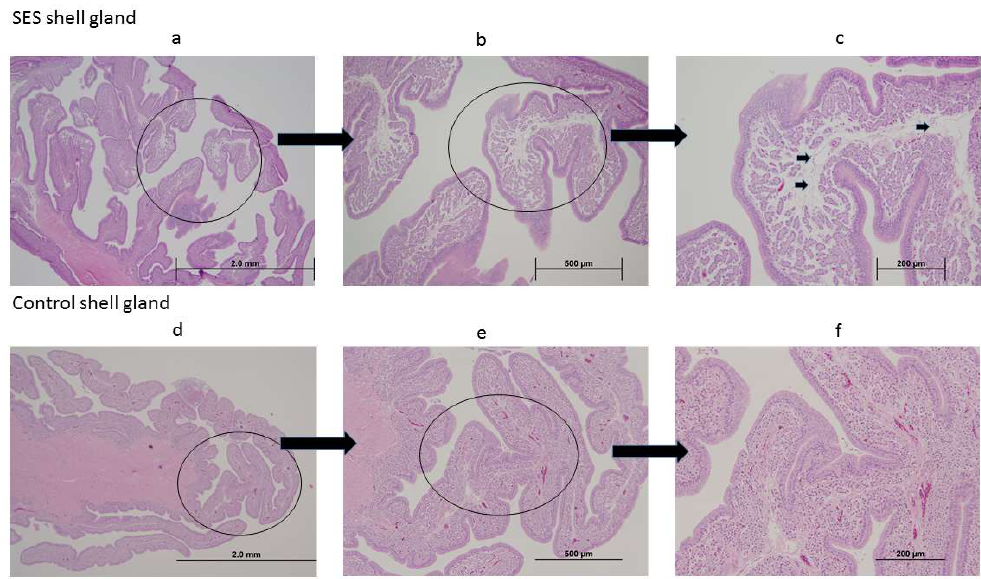
Figure 6. Histological changes following infection with Mass type Western Canadian IBV isolate, 15AB-01. Images ( a – c ) are representative images of the shell gland from IBV infected chicken, and the images ( d – f ) are representative images of the shell gland from uninfected chicken. Edema is shown using arrows in the image ( c ).